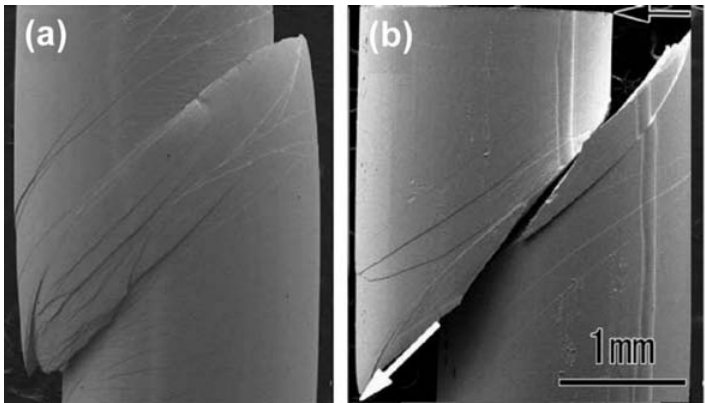
Figure 3. Two regimes of deformation observed in metallic glasses: ( a ) relatively homogeneous deformation with many shear bands in the Zr ( b ) stick-slip behavior in a single major shear band in the Zr Reprinted from [71] with permission of